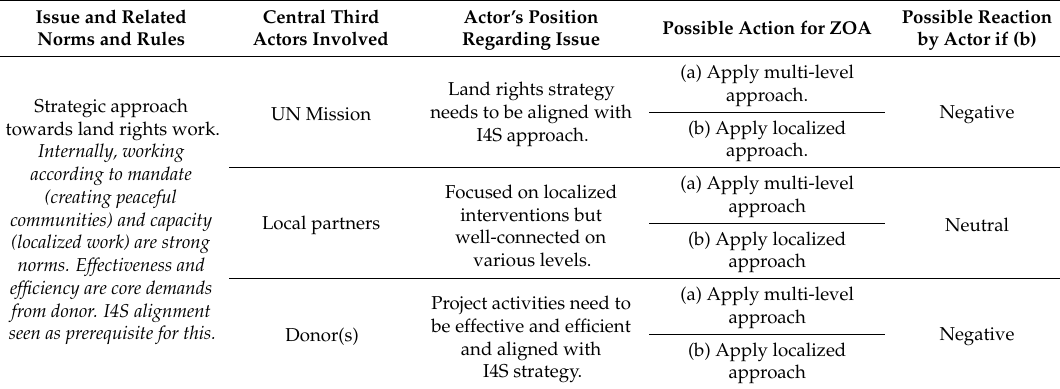
Table 2. Schematic representation of DRC case: land rights